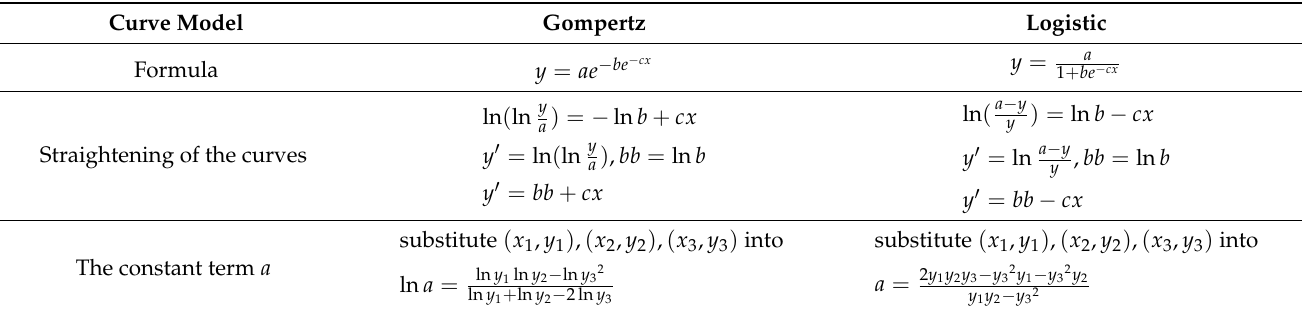
Table 2. Approximate nonlinear method fitting